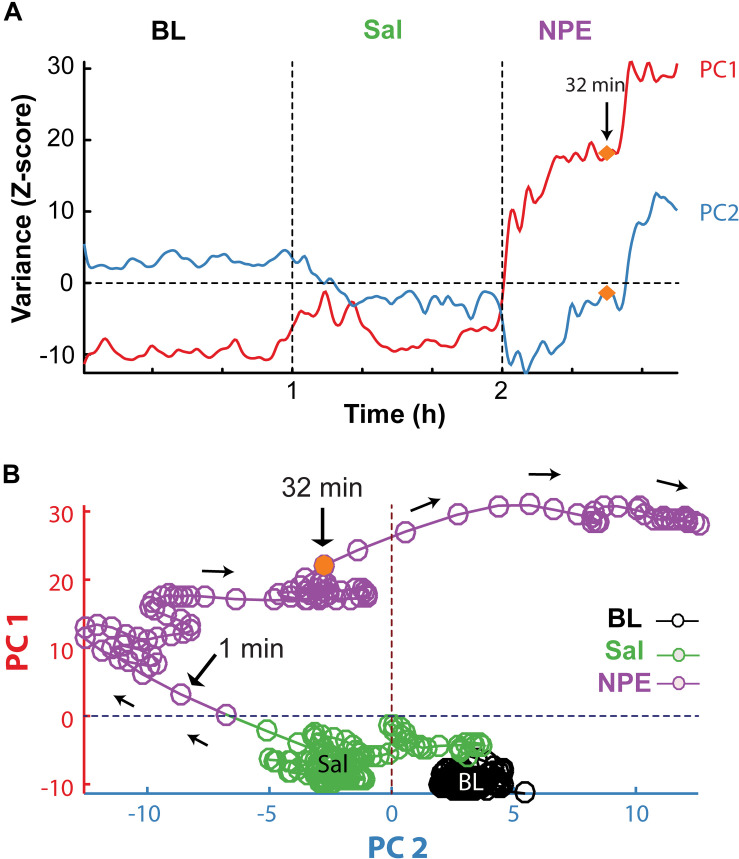
PCA population trajectory analysis unveil that NPE induced a dynamic pharmacological brain state. (A) The two first principal components as a function of time computed from the normalized NAcSh population PSTH activity. The first PC1 contains the contribution of neurons exhibiting increasing responses (PC1), whereas the second PC2 reflects the activity of decreasing responses after the onset of NPE. (B) Population trajectories projected into two-dimensional spaces, along the PC1 (increasing responses) vs. PC2 (decreasing responses). Each circle represents the population activity (in a 30 s bin size), and the color represents different epochs; BL (black circles), Sal (green circles), and NPE (purple circles). Note that neuronal activity in BL epoch remained around an attractor state. Likewise, activity slightly changed in the Sal epoch reflecting a non-stationary activity of the NAcSh. However, they again stayed in a new attractor state. In contrast, 1 min after administration of NPE, the population trajectories entered a different position in the PCA space. In both panels, the orange circle indicates 32 min after the onset of the NPE administration, where population trajectories changed once more.